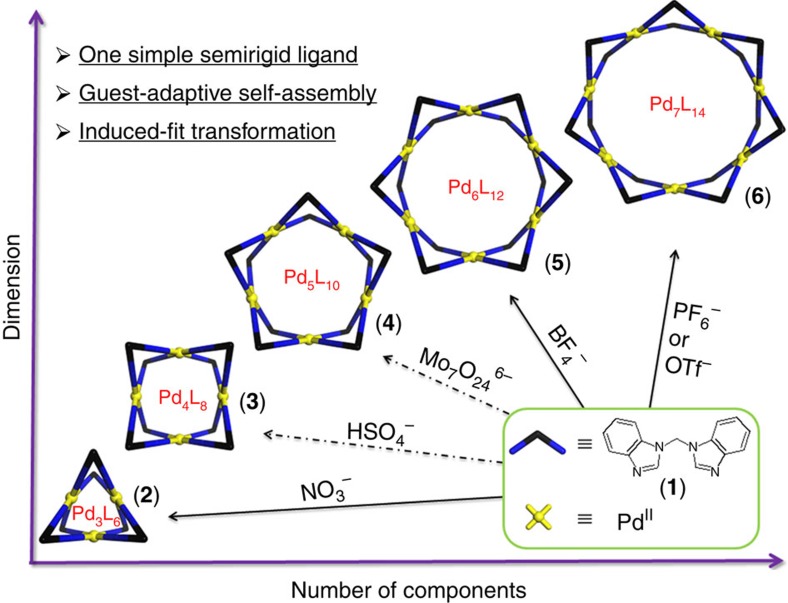
Self-assembly of anion-binding metal-organic macrocycles.Self-assembly of anion-binding metalorganic macrocycles with an empirical formula of PdnL2n (n = 3, 4, 5, 6, 7). Dashed arrows indicate that Pd4L8 and Pd5L10 were obtained by induced-fit transformation from other macrocycles instead of direct self-assembly.